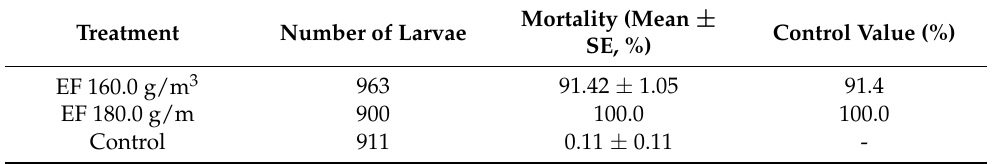
Table 4. Mortality of Curculio sikkimensis (ca. 300 larvae/replicate, N = 3) after 12 h of fumigation using ethyl formate (EF) at 15 ◦ C (filling ratio = 2.5%) on a small scale (2 m 3